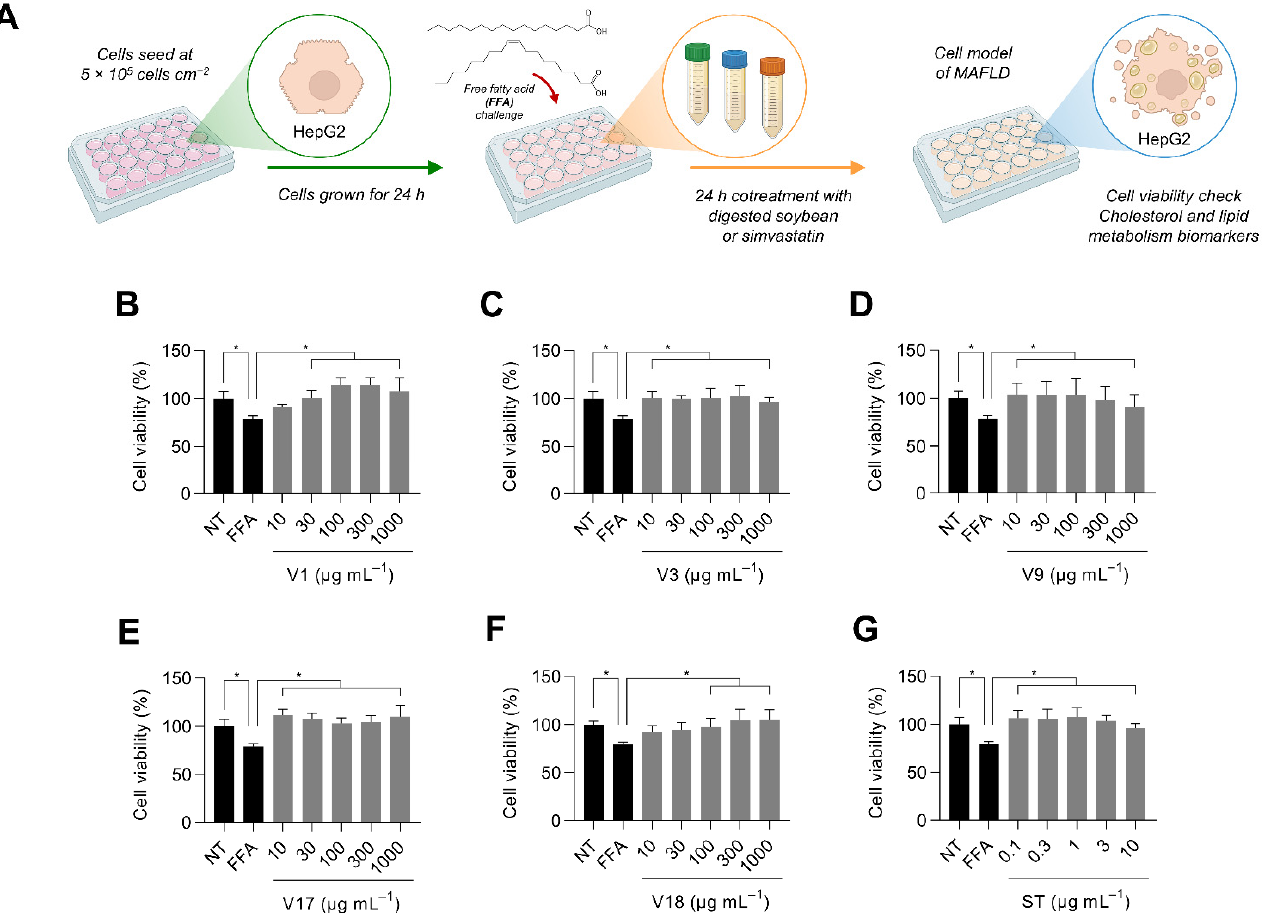
Figure 4. Illustrative diagram of the experimental design followed for evaluating the metabolic effects of digested soybean in liver cells under metabolic ‐ associated fatty liver disease (MAFLD) ( A ). Basal cell viability of selected digested soybean varieties ( B – F ) and simvastatin ( G ). Results are reported as mean ± SD ( n = 3). Bars that significantly ( p < 0.05) differ according to ANOVA and Dunnet’s multiple range test are marked with a superscript asterisk (*). NT: non ‐ treated cells; FFA: cells treated with free fatty acids (500 μ mol L − 1 oleic: palmitic acid, 2:1).